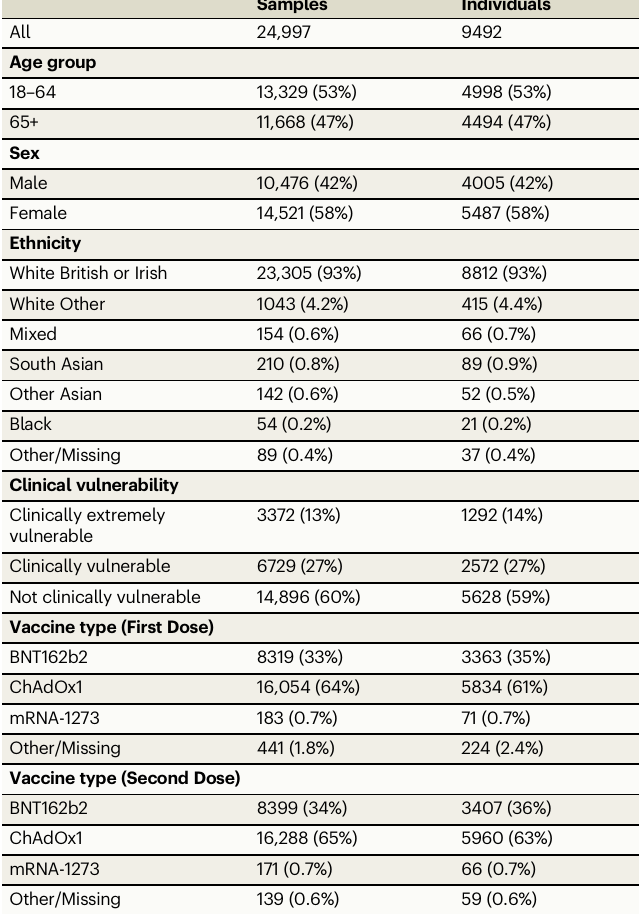
Table 1 | Demographic and clinical characteristics of included individuals and samples Samples